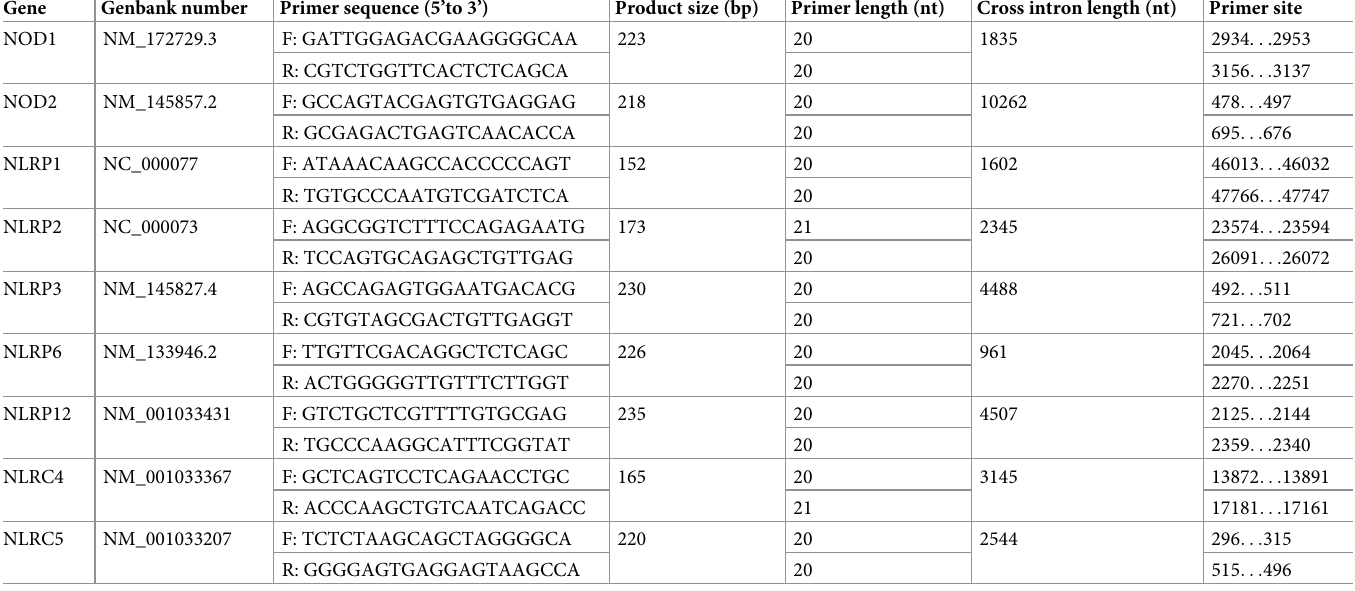
Table 3. Primers used for analysis of NLRs.